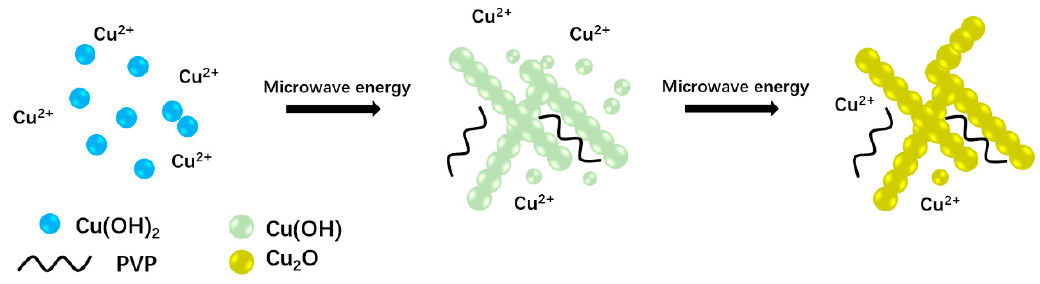
Figure 5. A Possible formation route of the one-dimensional Cu 2 O.